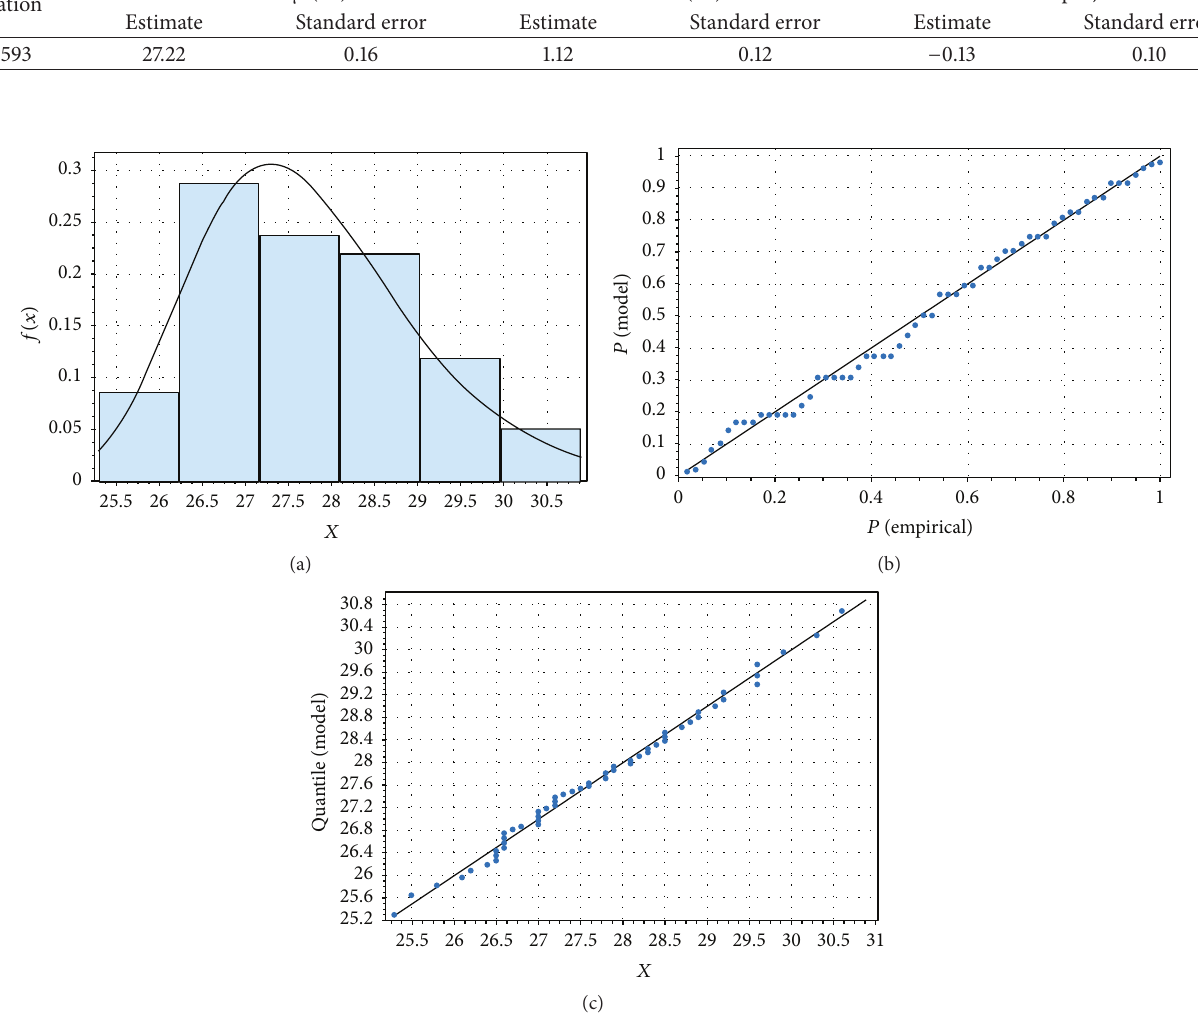
Figure 8: Diagnostic graphs of (a) probability density function, (b) P-P plot, and (c) Q-Q plot for fitting the annual maxima series in station 50593 to GEV